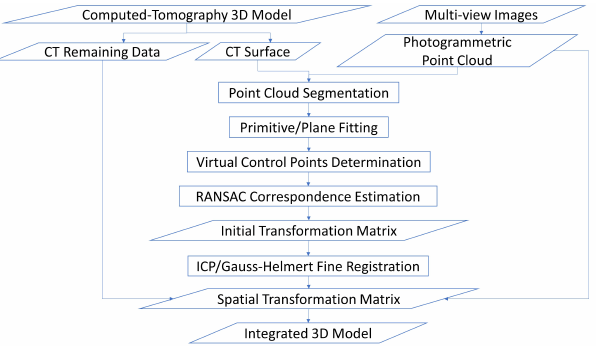
Figure 1. Virtual control points based registration workflow.